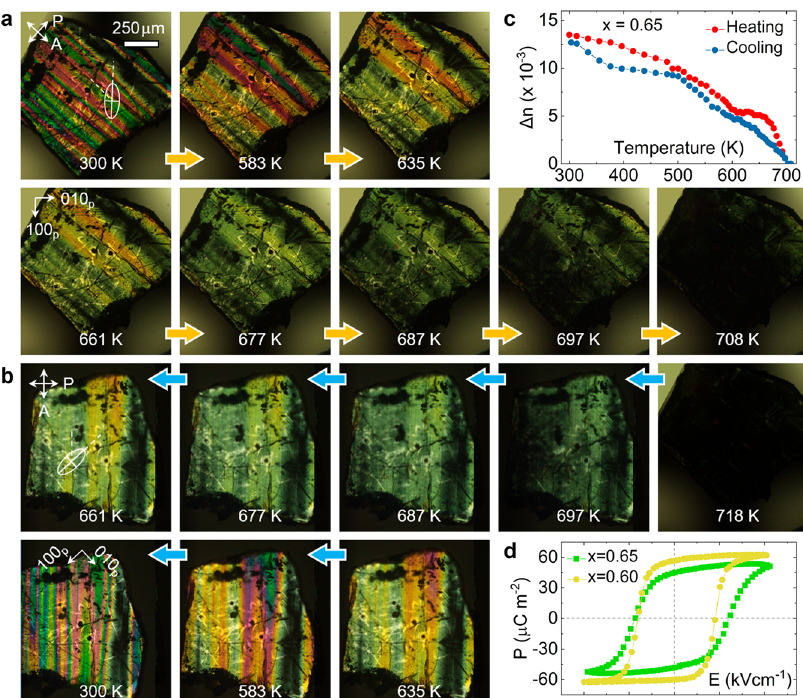
Fig. 4 Evidence of competing fi rst- and second-order transitions at x T around T C and ferroelectric anomaly. a , b Temperature-dependent ferroelastic tcr domain structure evolution in a pseudocubic (001) p platelet of the x = 0.65 PZT crystal observed during heating and cooling cycles by PLM, respectively. The polarizer (P), analyzer (A), and optical indicatrix are denoted on the image with respect to the crystallographic orientation. c Temperature-dependent birefringence data of the x = 0.65 PZT crystal. d P – E hysteresis loops of the x = 0.60 and 0.65 PZT crystals measured at room temperature with frequency f = 10